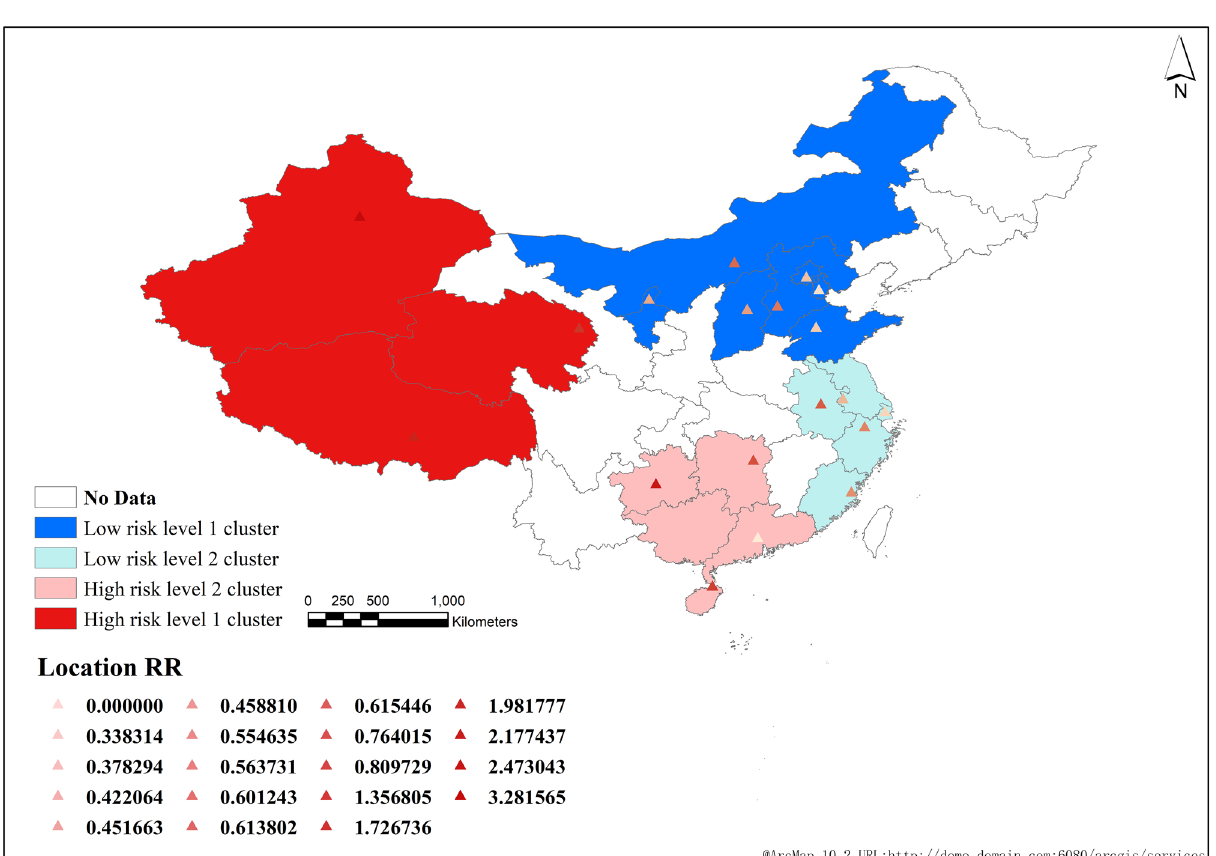
Figure 7. High-low space time scanning statistical analysis of reported cases of pulmonary tuberculosis in China from 2008 to